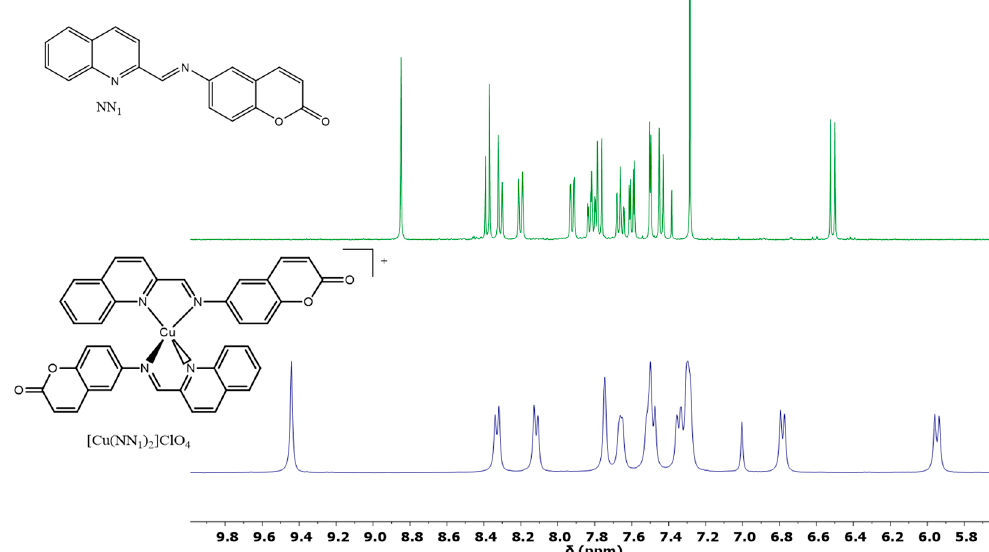
I (NN 1 ) 2 ](ClO 4 ) (blue) in CDCl 3